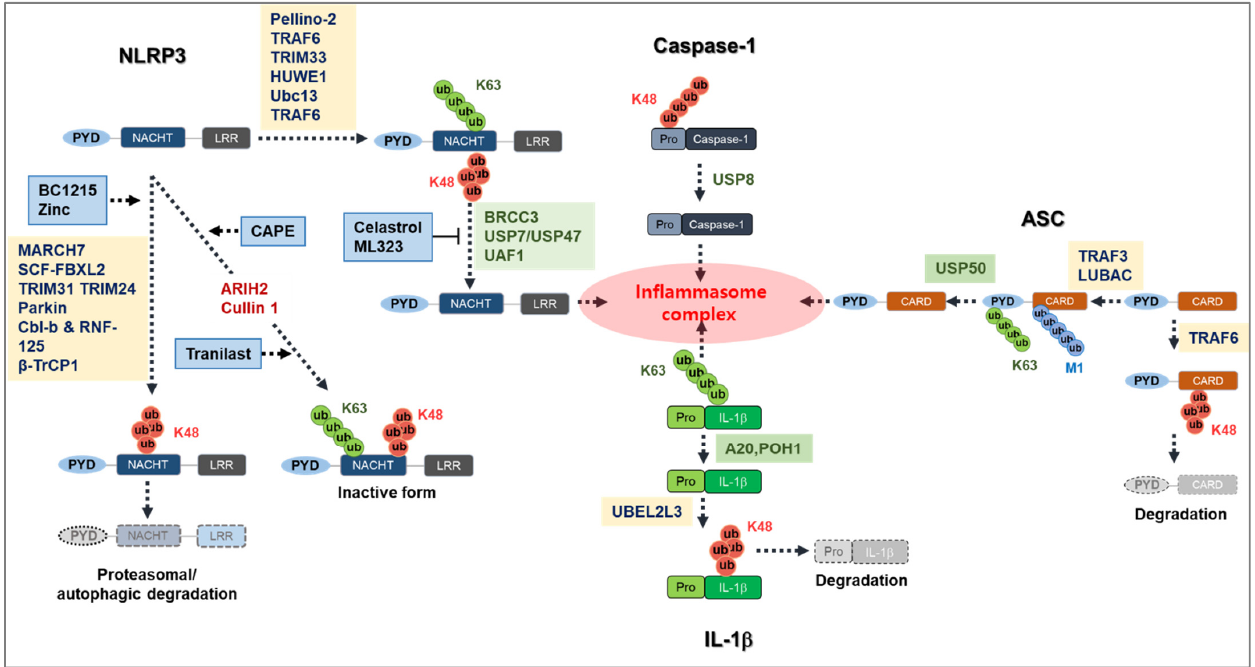
Figure 2. Overview of ubiquitin-mediated regulation of NLRP3 inflammasome activation. Yellow indicates ubiquitin ligases and green indicates deubiquitinase (DUB). Blue indicates the proposed molecules that inhibit NLRP3 inflammasome activation by modulation of ubiquitination.